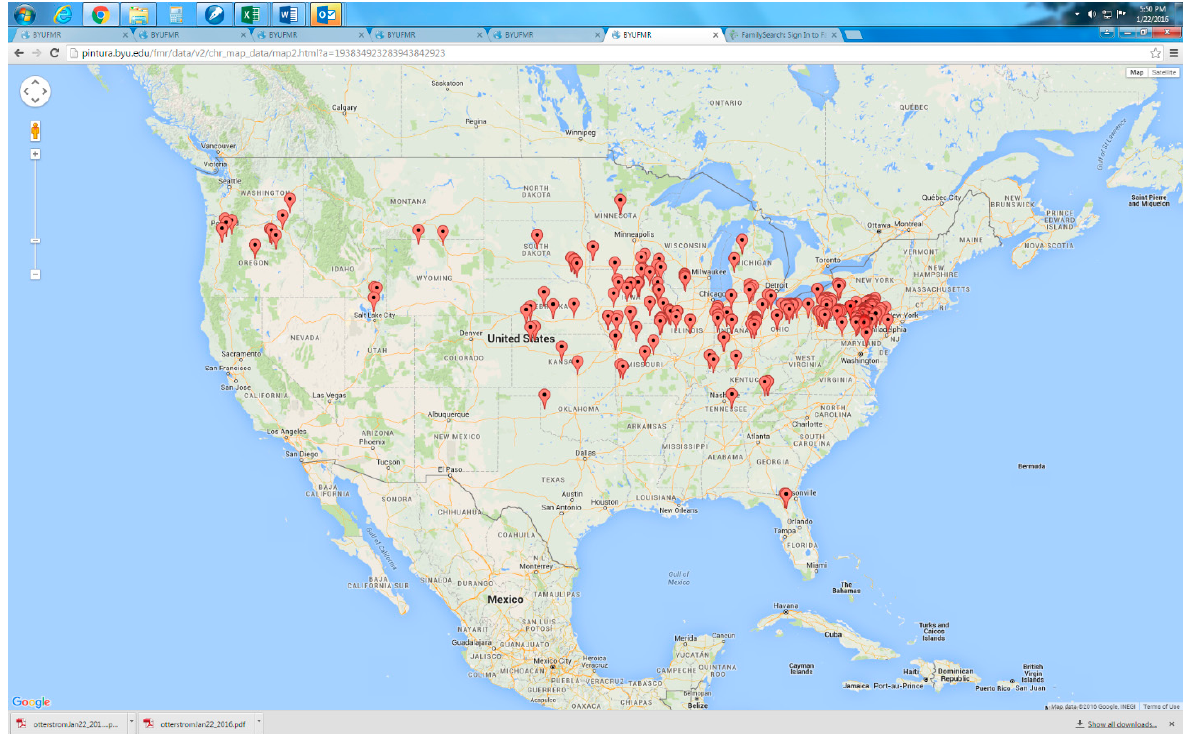
Figure 5. Birth locations of grandchildren of individuals born in Pennsylvania in 1820.